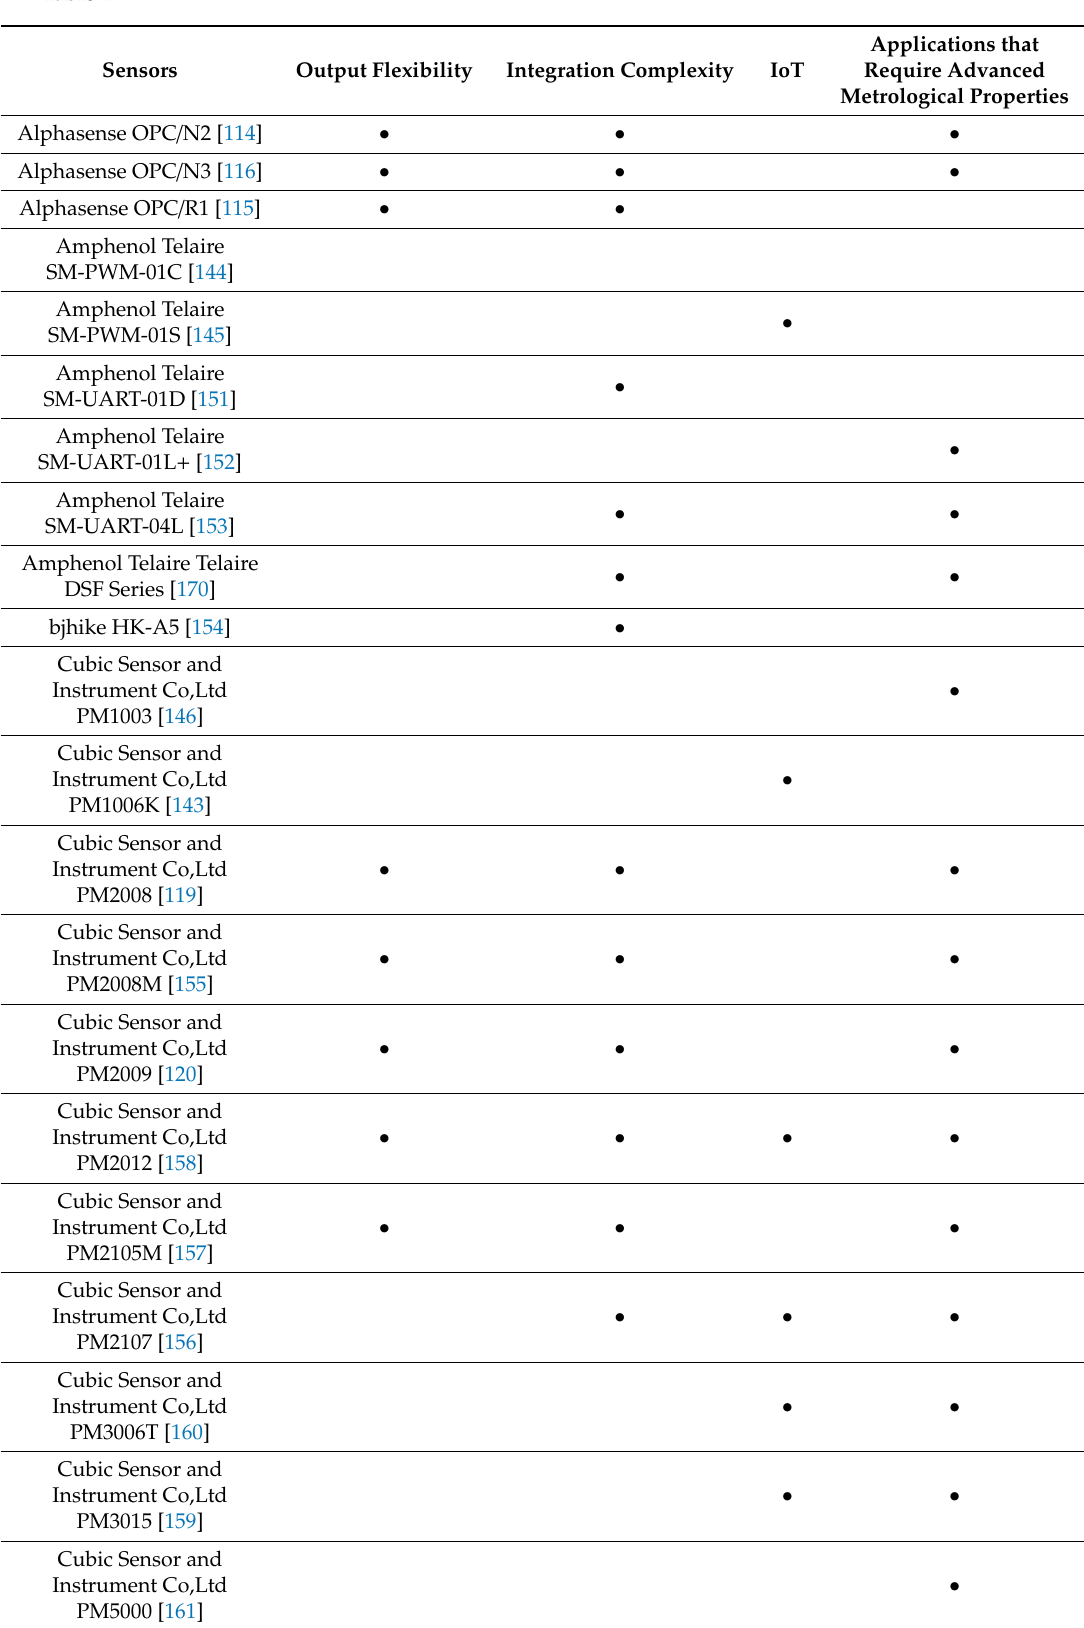
Table 7. LCPMS grouped according to the four application scenarios defined for the devices listed in Table